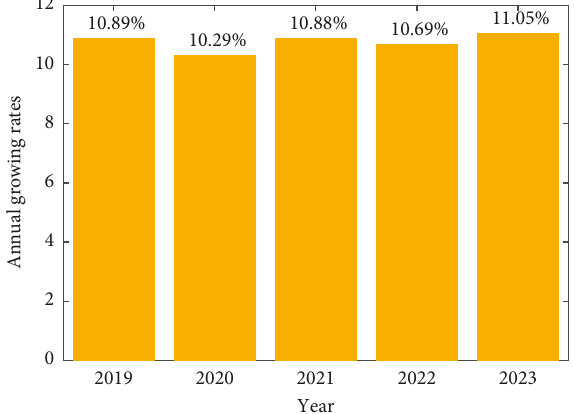
Figure 4: Increasing rates of annual GDP from 2019 to